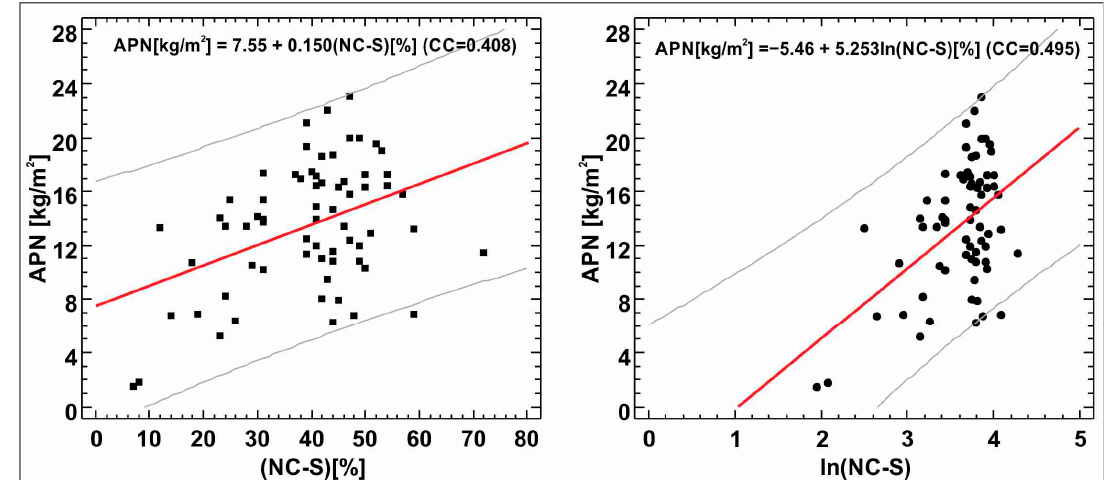
Figure 7. Simple linear relationship between APN and (NC-S) (left) and APN and ln (NC-S) (right); CC—correlation coefficient.